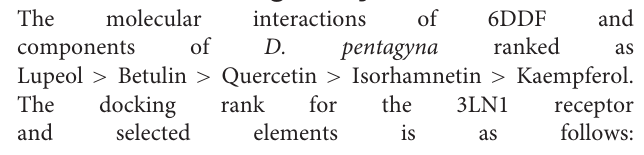
Effects of various test doses of the MEDP on the castor oil induced diarrhea test in mice (n = 6). Values are presented as mean ± SEM; One-way analysis of variance (ANOVA) followed by Dunnett’s test. **p < 0.01, and ***p < 0.001 is considered as significant compared with the control, where # is designated as